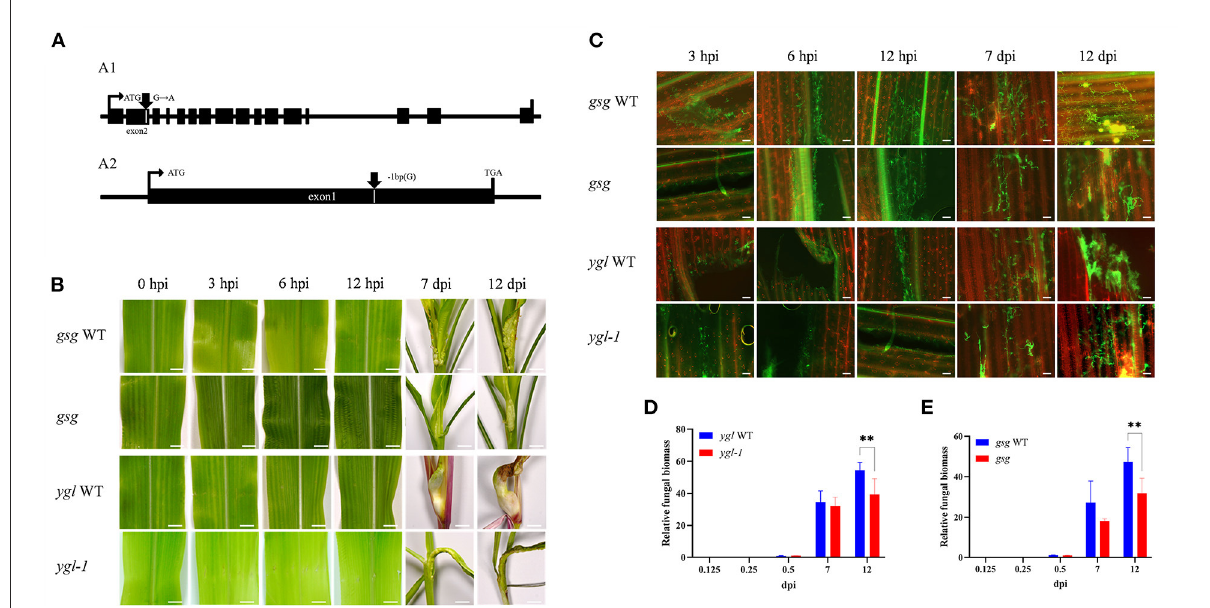
FIGURE9 Maize mutants defective in sugar and chlorophyll biosynthesis showed resistance to Ustilago maydis infection. (A) Schematic diagrams showing the genomic structures of the mutants; (A1) transition mutants showing the gsg allele with the G/A base transition in the second exons, (A2) deletion mutant showing a 1-bp nucleotide deletion in the first exons. (B) Comparison of symptoms in the two maize mutants ( gsg and ygl-1 ) defective in sugar and chlorophyll biosynthesis with the wild-type leaves after U. maydis inoculation. Inoculated leaves were collected at 3, 6, 12, 7, and 12 dpi, respectively to compare the phenotypes. Scale bar = 1cm. (C) Growth of U. maydis in the mutants and wild-type plants was analyzed by staining with WGA-AF488 (green). The plant cell wall was stained with propidium iodide (red). Scale bar = 50 µ m. (D,E) Relative fungal biomass of mutants calculated based on the amount of genomic DNA detected by real-time PCR. Plant-specific (GAPDH) and fungal-specific ( ppi ) gene primers were used to analyze WT (blue bars) and mutant (red bars) data at 0.125, 0.25, 0.5, 7, and 12 dpi, respectively. Each error bar represents the SD of three biological replicates. Asterisks indicate statistical significance ( t -test; ** P <